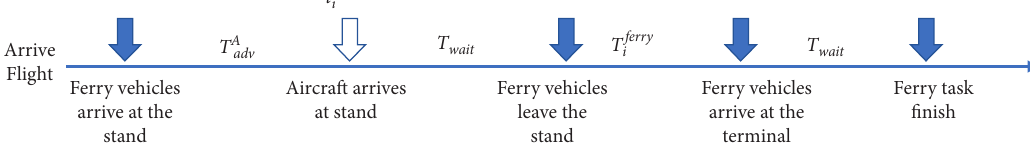
Figure 6: Ferry vehicle service process of arrival flight.